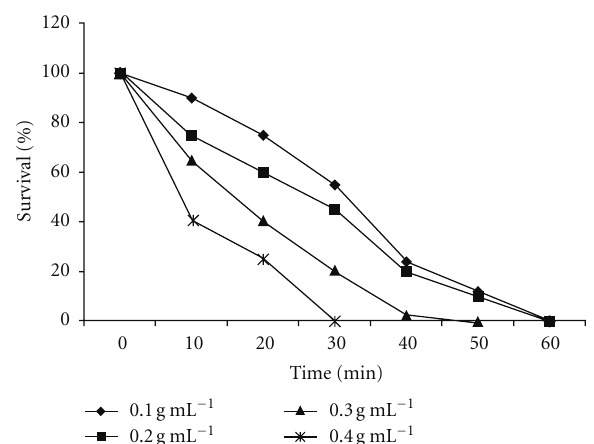
Figure 2: Antitermitic activity of 70% alcoholic extracts of P. biglo- bosa .